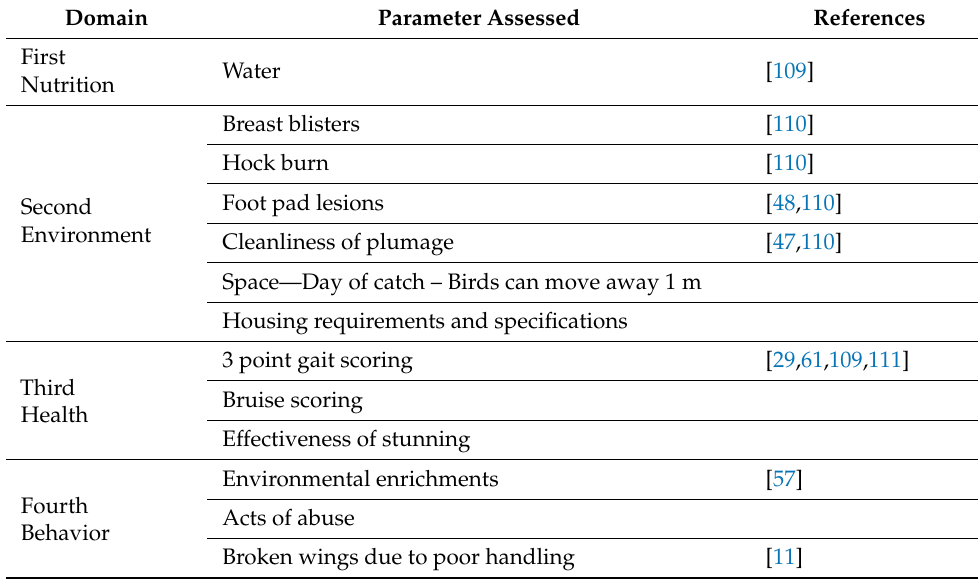
Table 5. Key Welfare Indicators for Broiler